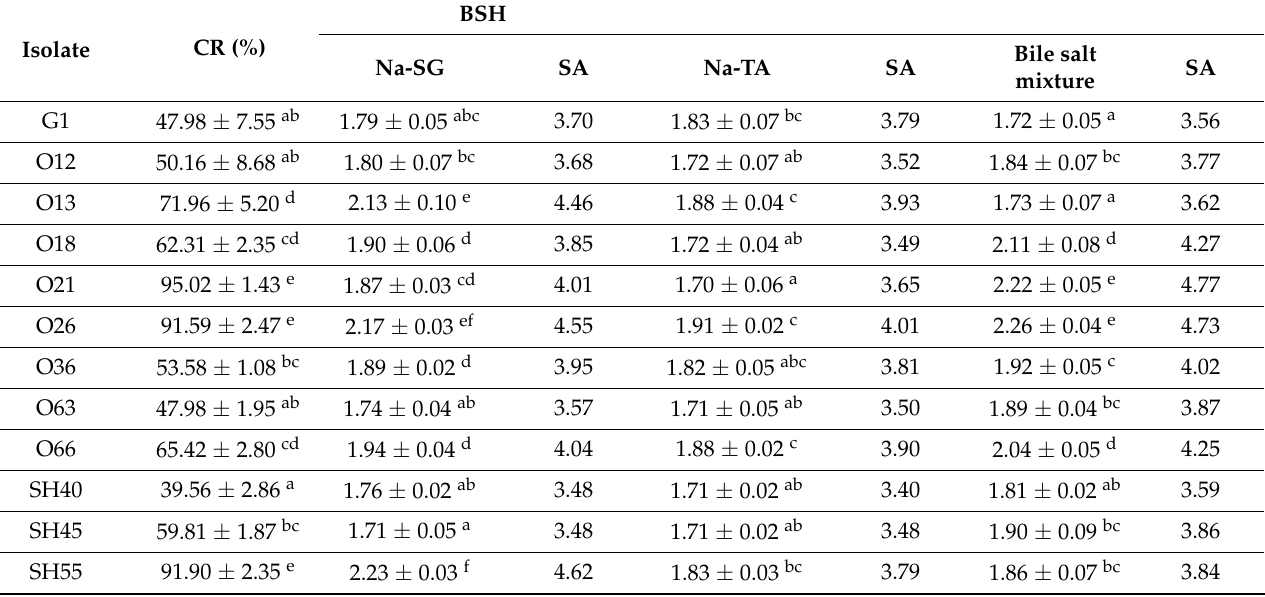
Table 2. Cholesterol removal (%) and bile salt hydrolase (BSH) activities (specific activity, U/mg) of 12 potential probiotic